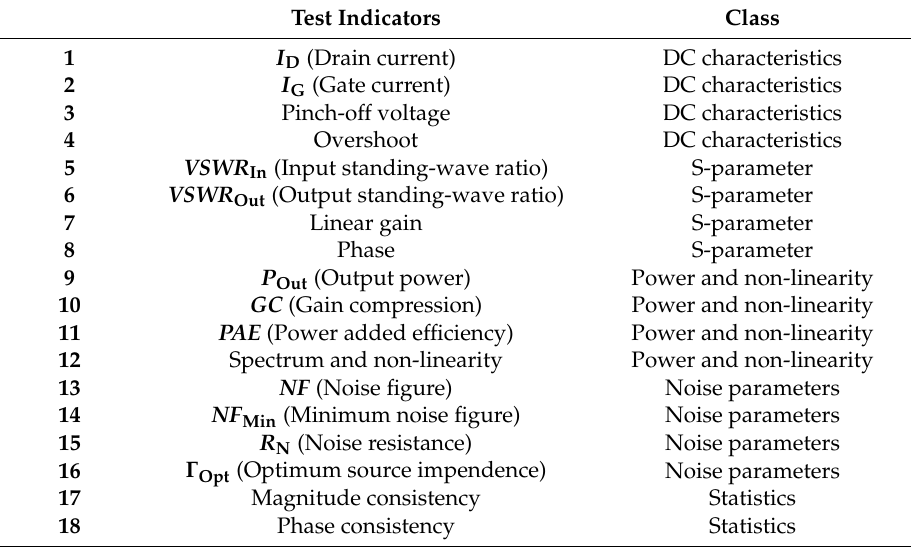
Table 1. Typical MMICs’ test indicators and classification.